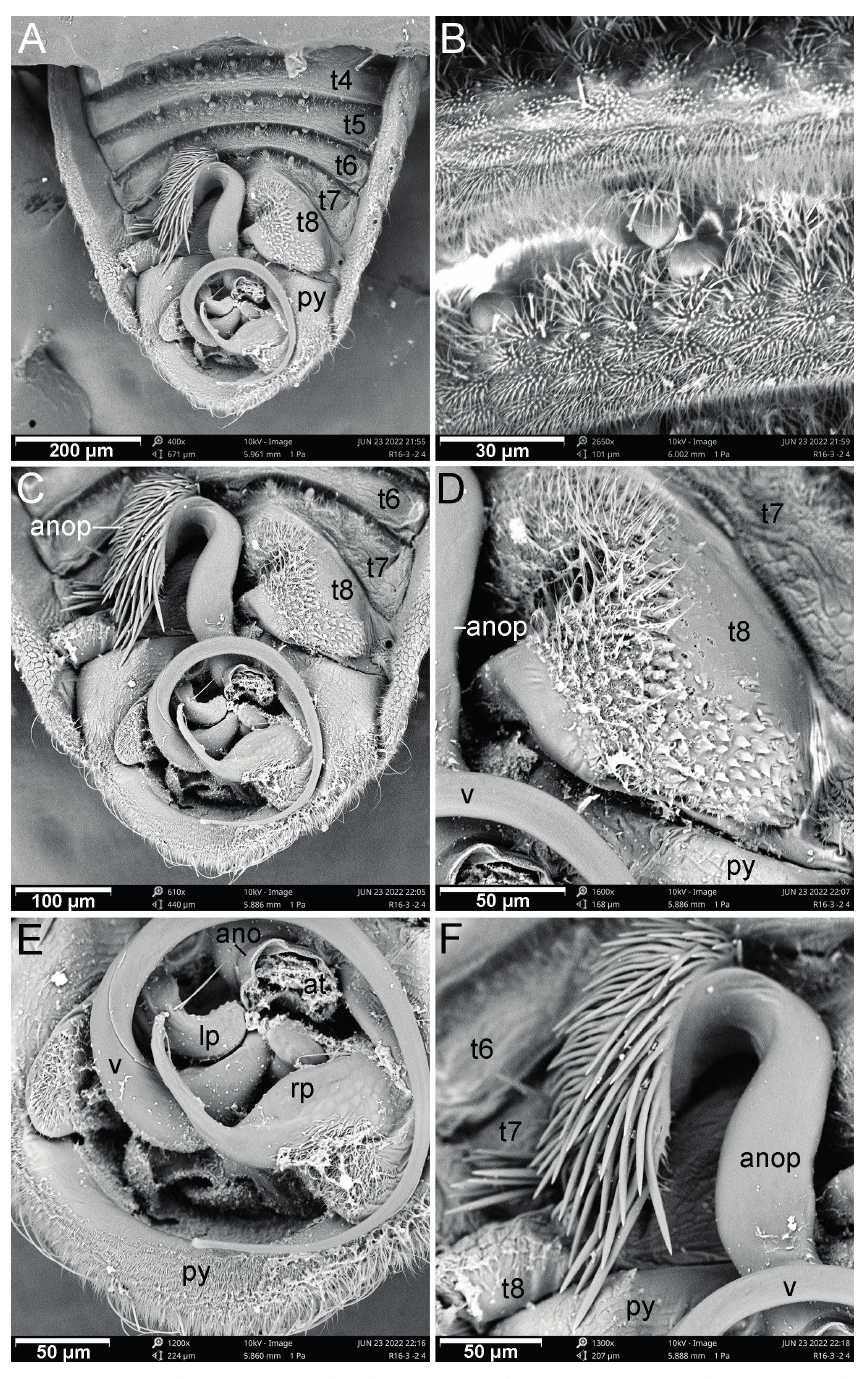
Figure 7. Scanning electron micrographs of Cornonannus bui gen. et sp. nov., male paratype in dorsal view A abdomen B groove and tubercles on tergite V C apex of abdomen D right region of tergite VIII E genitalia F apex of anophoric